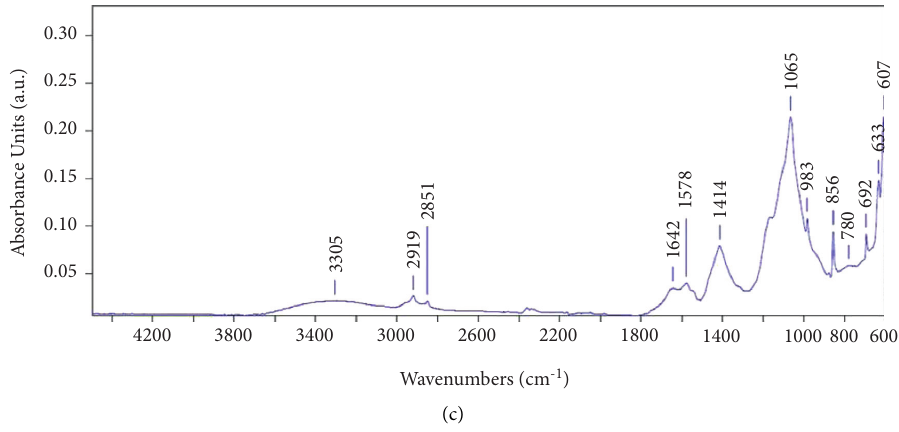
Figure 12: The pattern of infrared analysis of flaxseed oil. The color medium of the printing ink blue stamp (a) and red stamp (b).